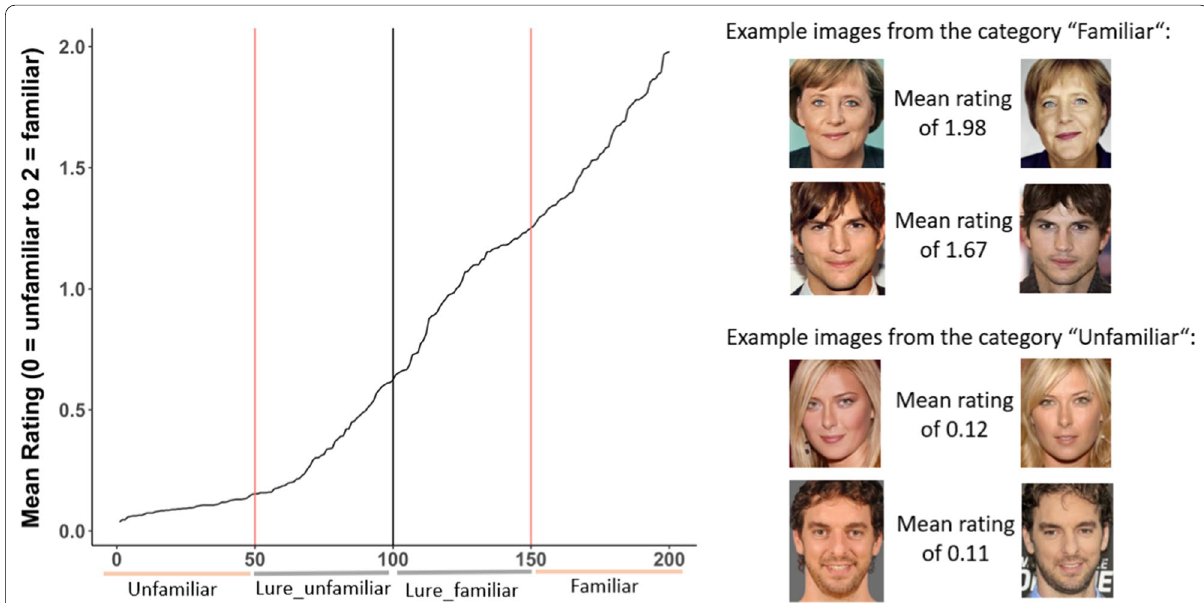
Fig. 1 Familiarity rating for faces of 200 identities. Note. The plot on the left shows the mean rating of familiarity for a given identity. In total, 200 identities were rated based on two different frontal pictures. The right side of the figure illustrates the mean rating across all participants for four sample